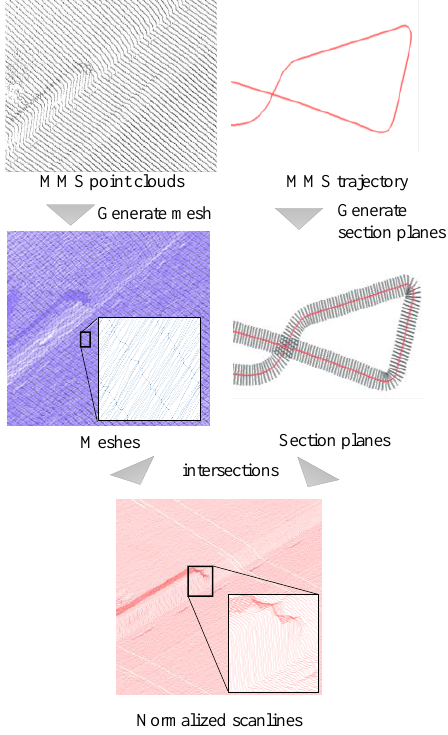
Figure 2. Process for creating normalized scanlines